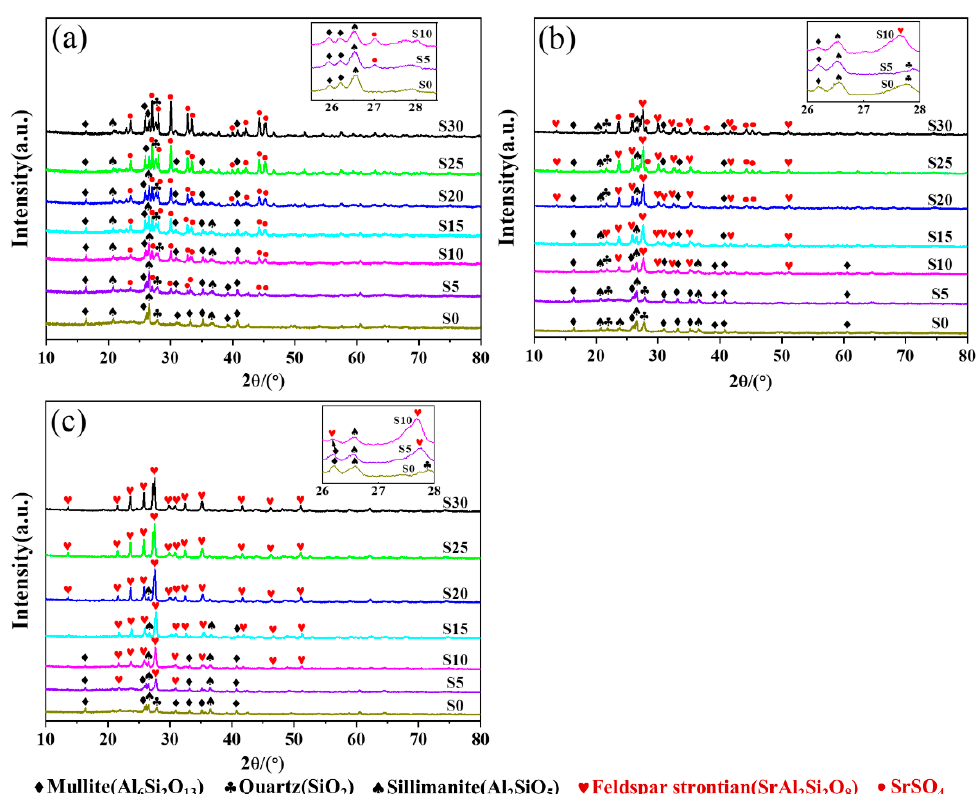
Figure 3. XRD patterns of the sintered forms doped with various amounts of SrSO 4 prepared at different temperatures: ( a ) S0-S30 at 1100 °C, ( b ) S0-S30 at 1200 °C, and ( c ) S0-S30 at 1300 °C.